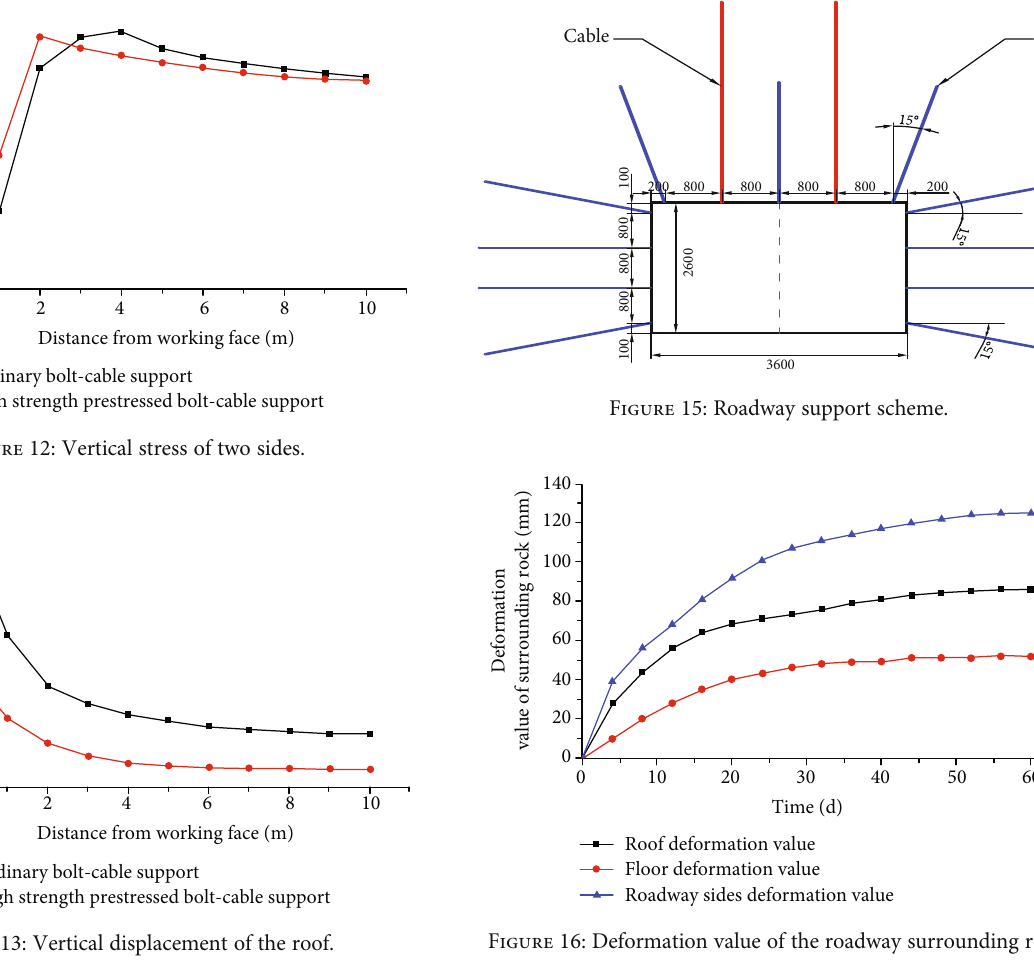
Figure 13: Vertical displacement of the roof.